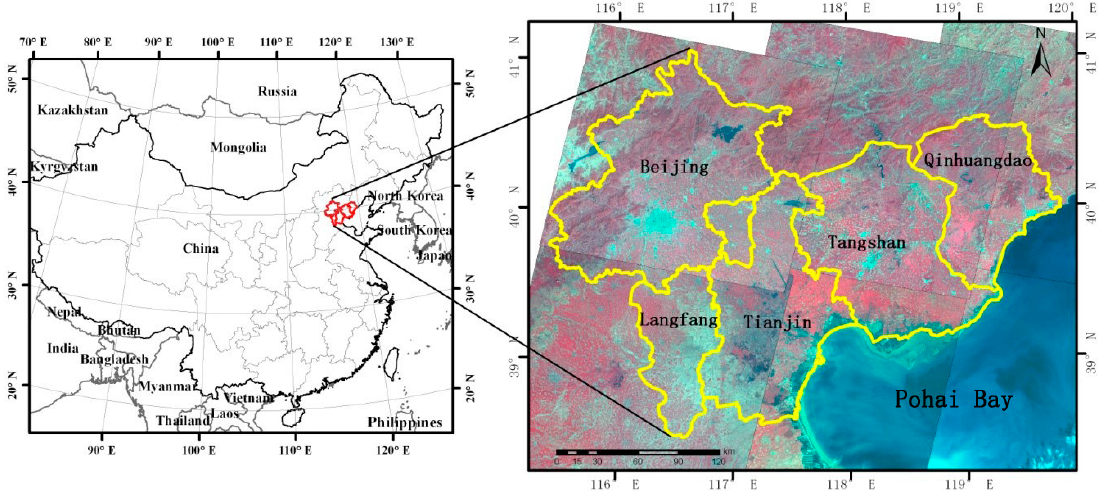
mosaic (red-green-blue (RGB): Bands 4, 3 and 2, respectively) of Landsat Enhanced Thematic Mapper (ETM) images. The cities of Beijing, Langfang, Tianjin, Tangshan and Qinhuangdao compose the urban agglomeration.